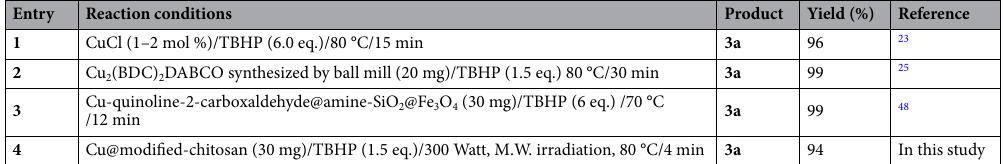
Table 5. Comparison of the catalytic activity of Cu@Sal-CS with other similar catalysts reported in the literature for preparation of carbamates.